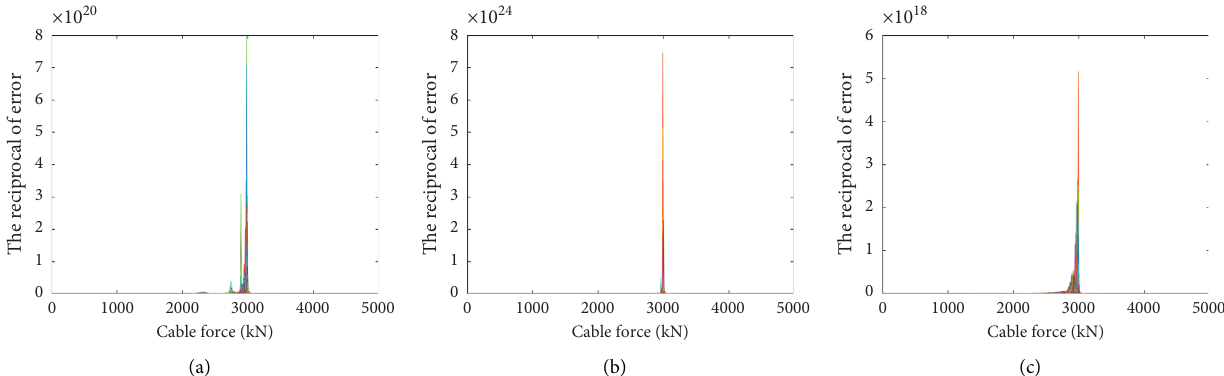
Figure 15: Cable force identification diagram corresponding to the frequency response of (a) point 1; (b) point 2; and (c) point 3.